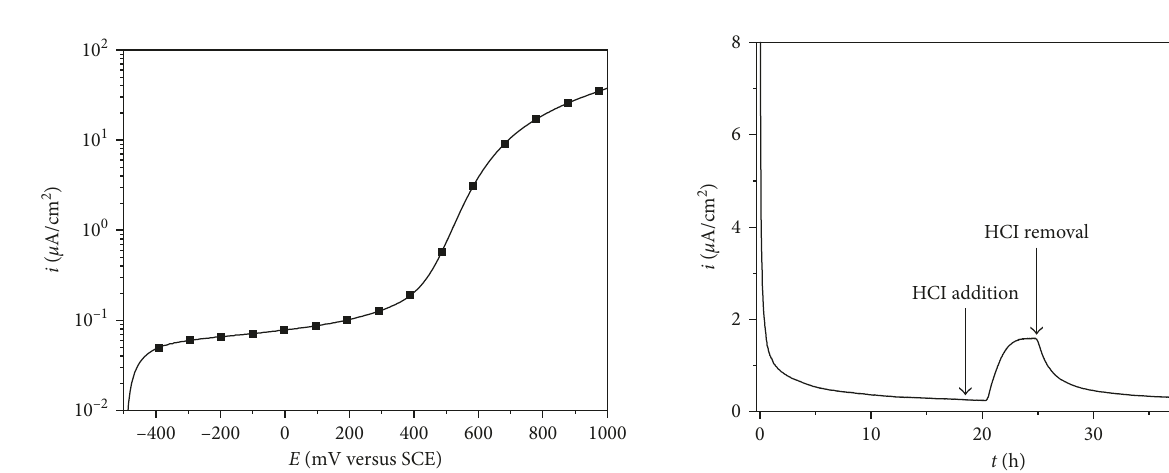
Figure 5: A typical current density versus time curve measurement in passivation and permeation experiment in 16.5% HCl for steel